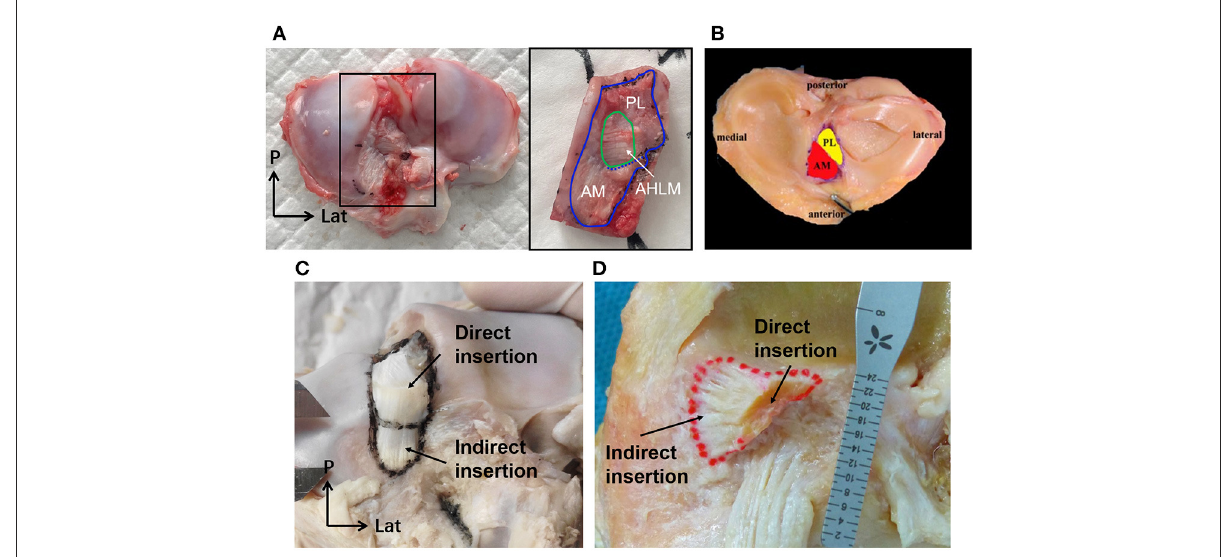
FIGURE6 The tibial insertion of porcine and human ACLs. (A) The AHLM split the porcine tibial insertion into AM and PL bundles. (B) The AM and PL bundle of the tibial insertion for a human ACL. (C) The direct and indirect tibial insertion pattern of a porcine ACL. (D) The direct and indirect tibial insertion pattern of a human